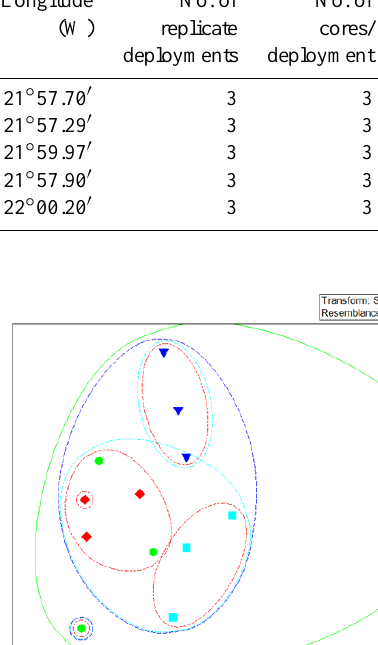
Table 1. Depth and position of stations sampled on and near Senghor Seamount. Station Depth Latitude